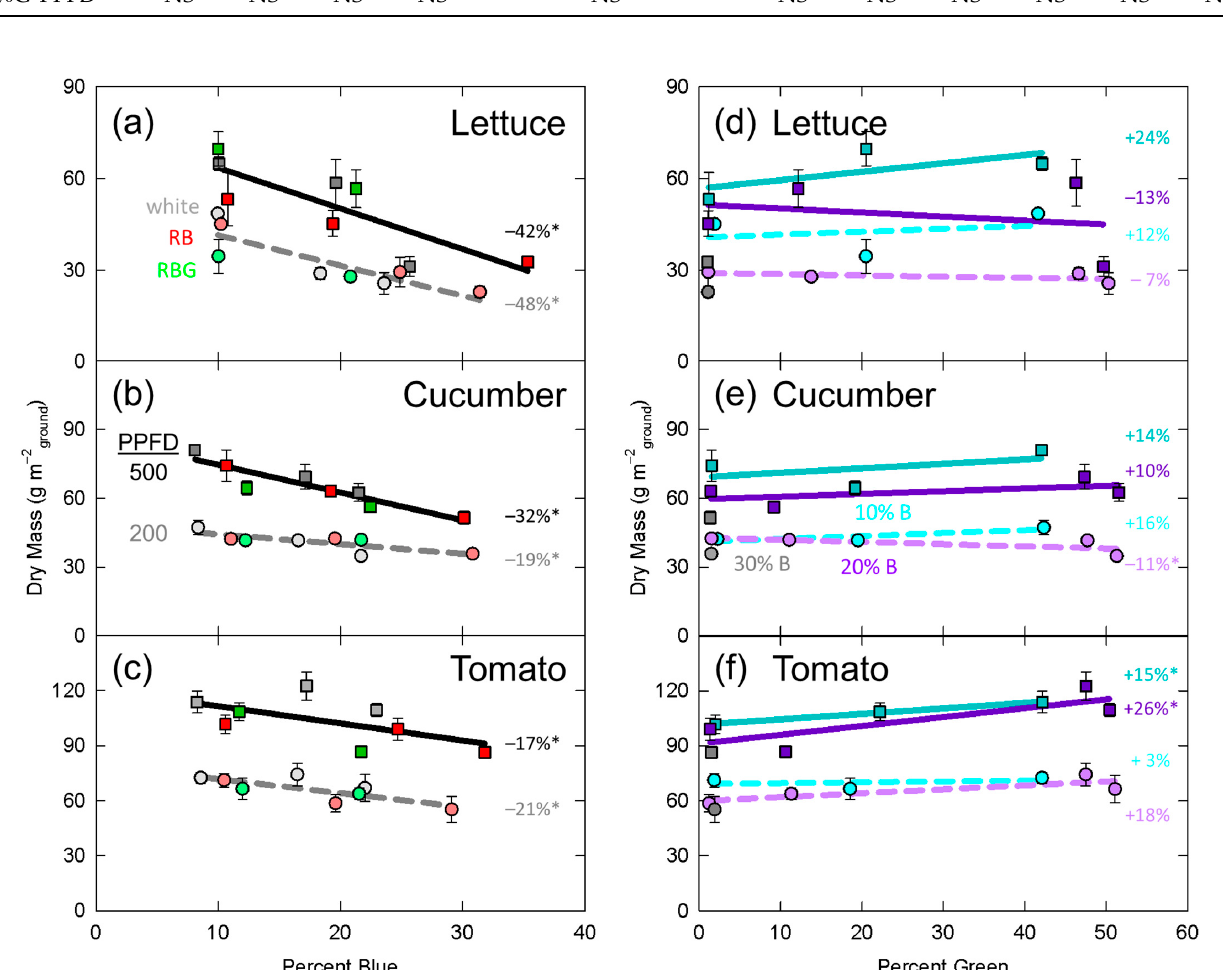
Figure 3. (a–c) Effect of percent blue on total dry mass in (a) lettuce, (b) cucumber, and (c) tomato. Squares and the solid black line represent the high intensity treatments (PPFD = 500 µmol m − 2 s − 1 ) and circles and the dashed grey line represent the low intensity treatments (PPFD = 200 µmol m − 2 s − 1 ). Red data points represent RB treatments, green points are RBG treatments and grey points are white LED treatments. The values in percent indicate the change from 10 to 30% blue. (d–f) Effect of percent green on dry mass in (d) lettuce, (e) cucumber, and (c) tomato. Solid lines and squares represent the high intensity treatments while the dashed lines and circles represent the low intensity treatment. The cyan data represent treatments with about 10% blue (10% B) and the purple data represent treatments with about 20% blue (20% B). The values in percent indicate the change from zero to 50% green. * represents a significant effect of percent blue or percent green at the p < 0.05 level. Error bars represent normalized standard error of n=3 replicates. RB: rad/blue; RBG: red/blue/green. PPFD: photosynthetic photon flux density.